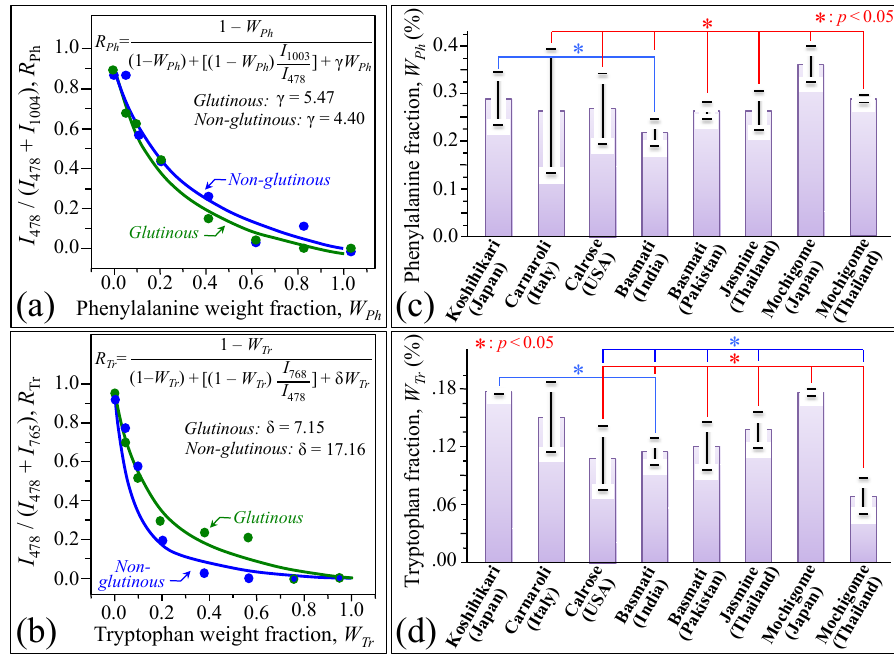
Figure 6. Raman calibration plots of ring vibrational signals (normalized to glucose ring stretching band at ~478 cm − 1 ) vs. weight fractions of ( a ) phenylalanine (Raman sub-band ratio R Ph = I 1003 / I 478 vs. W Ph ) and ( b ) tryptophan (Raman sub-band ratio R Tr = I 768 / I 478 vs. W Tr ); fitting equations and related constant are given in inset. In ( c , d ), percent weight fractions of phenylalanine and tryptophan, respectively; standard deviations are computed over 30 measurements at different locations per each type of rice and statistical validation according to Student’s t -test according to labels in inset.